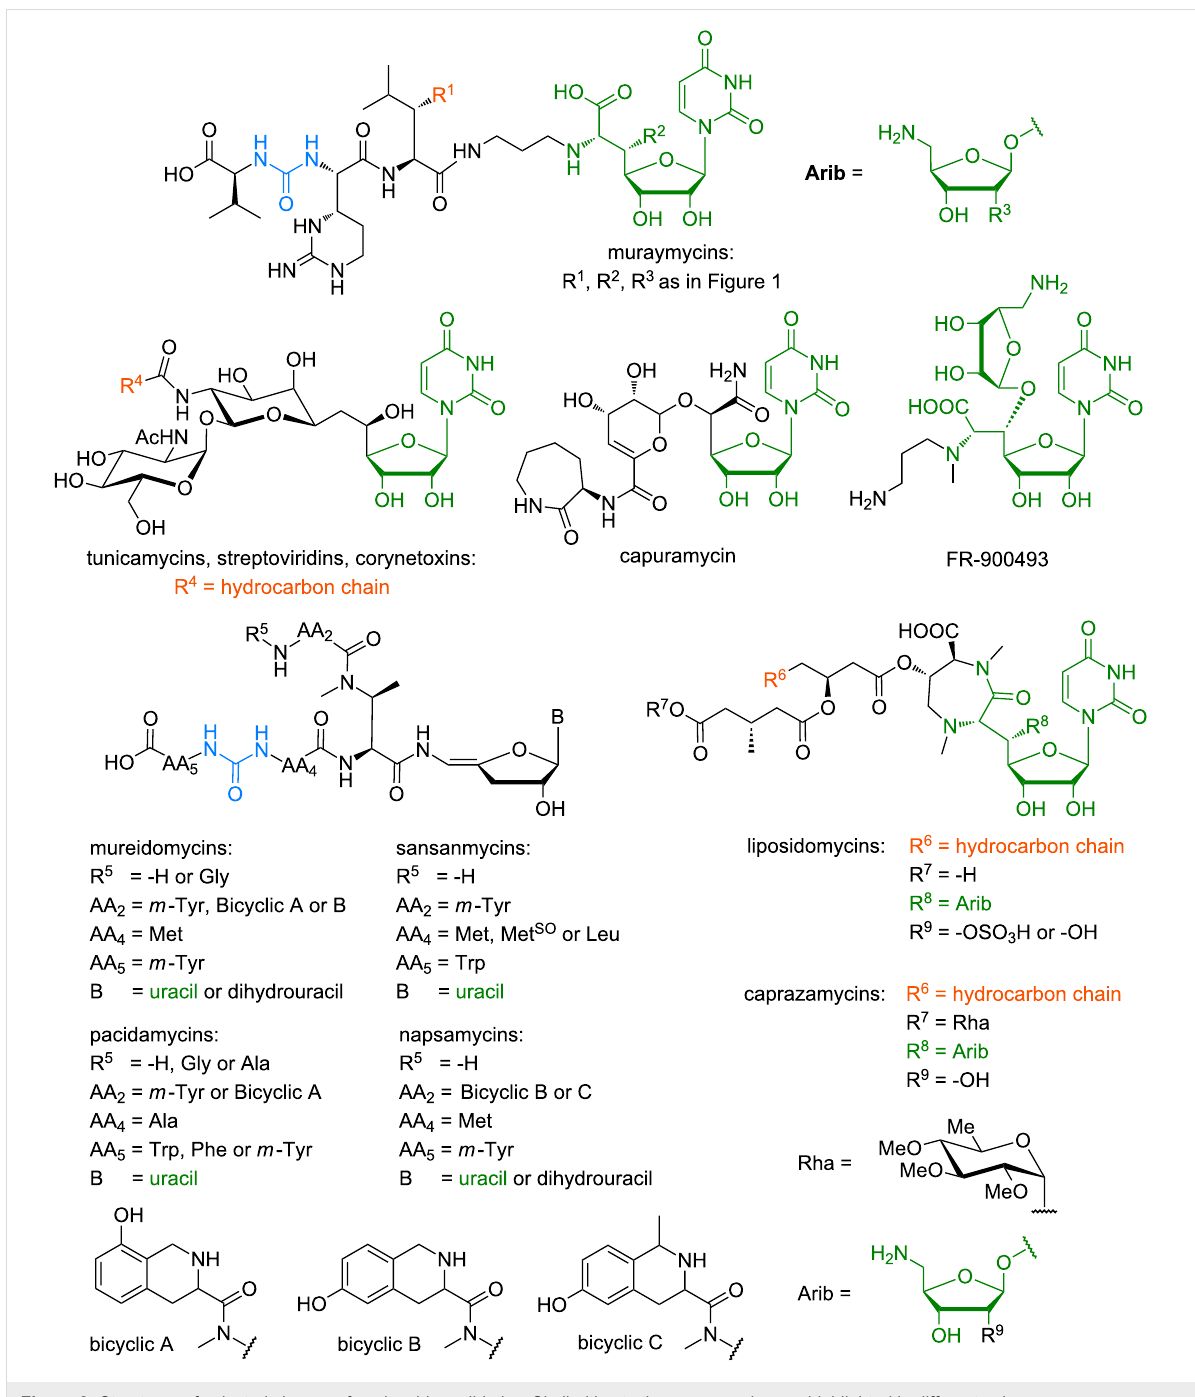
Figure 2: Structures of selected classes of nucleoside antibiotics. Similarities to the muraymycins are highlighted in different colours.